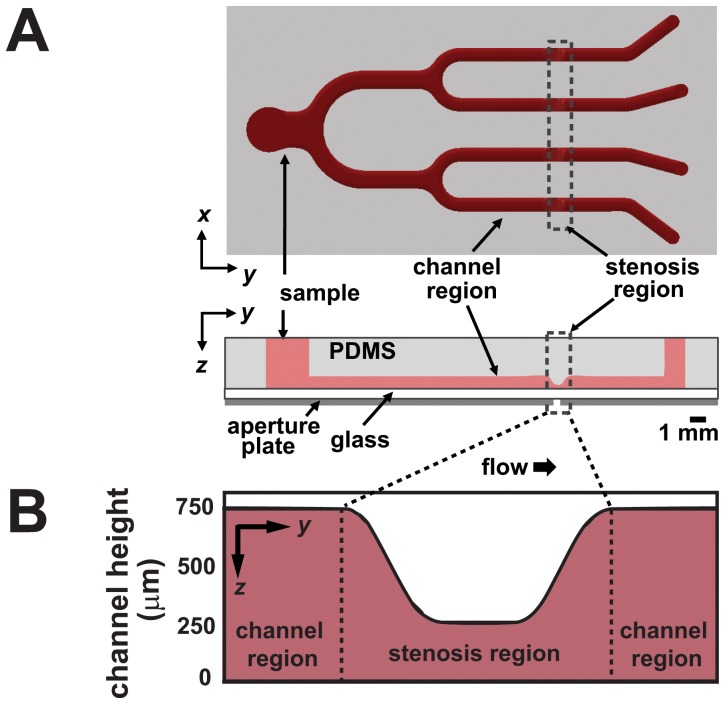
Schematic images of the microfluidic chip.The complete device is shown in (A) with detailed view of the stenosis region (B). From a single inlet, four branching channels subject the blood flow to a range of shear rates from physiological to pathological conditions. Dimensions of all four stenoses within the device are identical, with varying shear rates imposed by resistive tubing at the outlet ports.